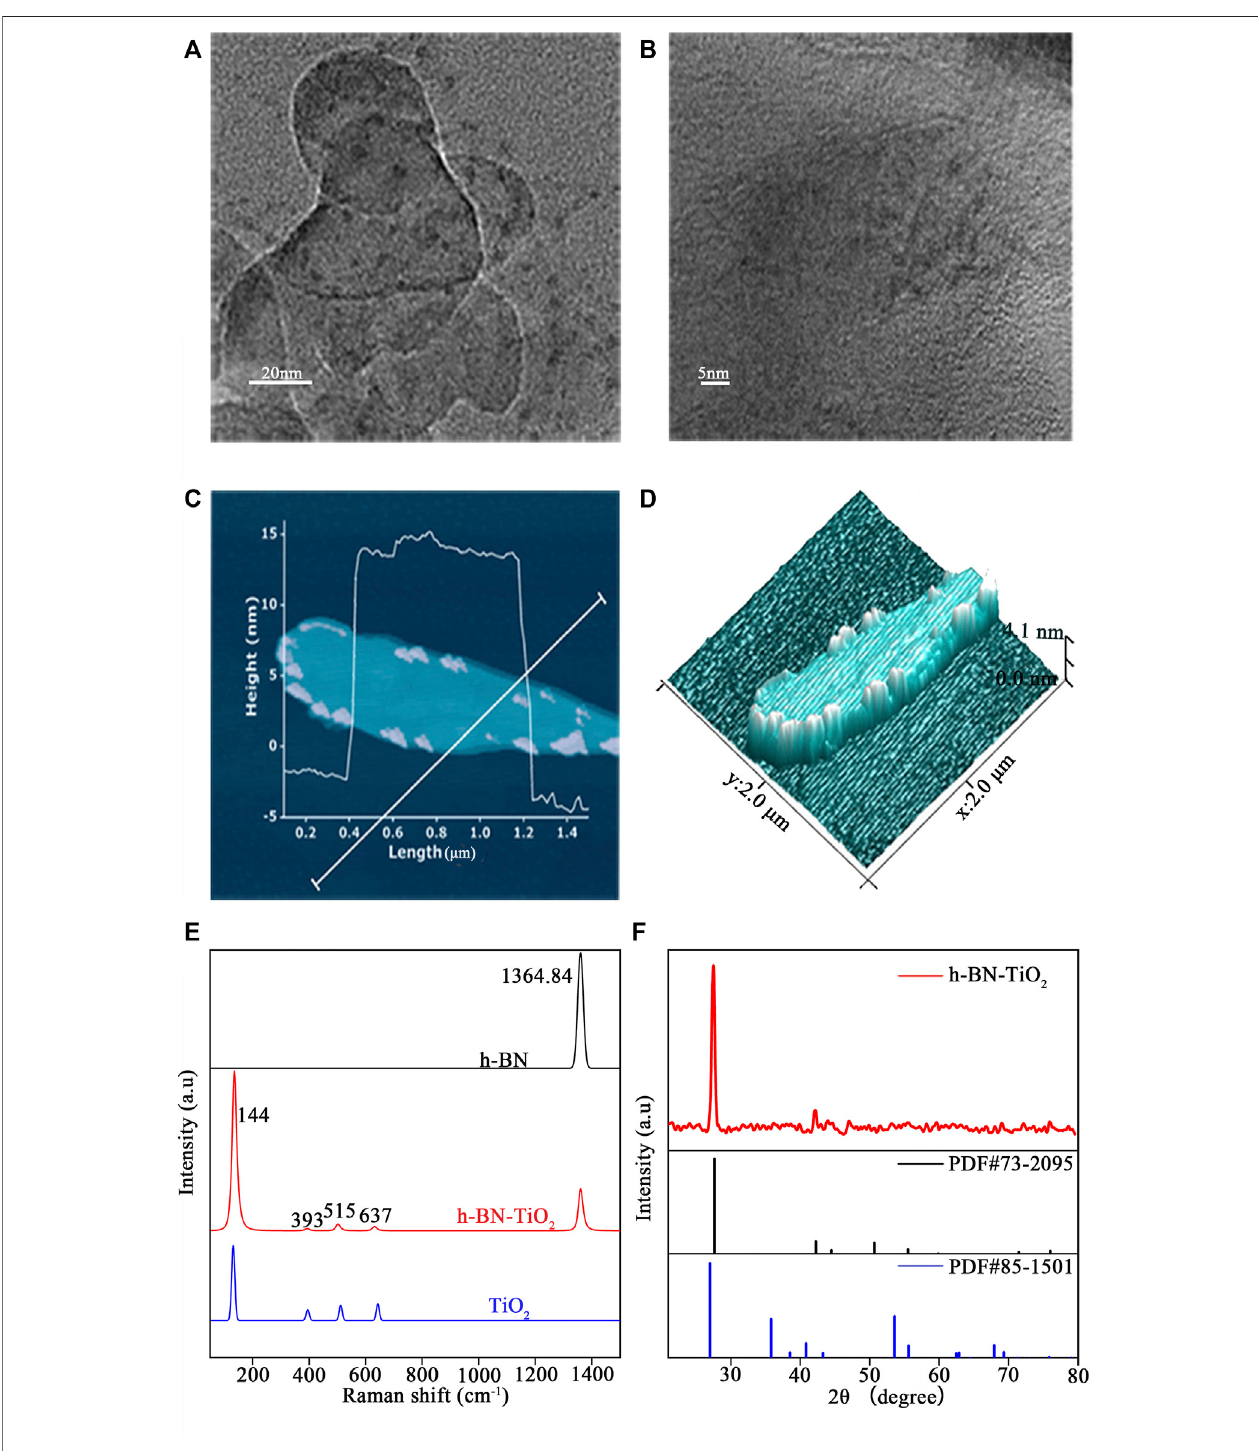
FIGURE 3 | TEM analysis of h-BN-TiO 2 by low (A) and high (B) magni fi cation images. And the prepared h-BN-TiO 2 (C,D) were observed by AFM. Raman spectrometry (E) and XRD patterns (F) of prepared h-BN-TiO 2 .